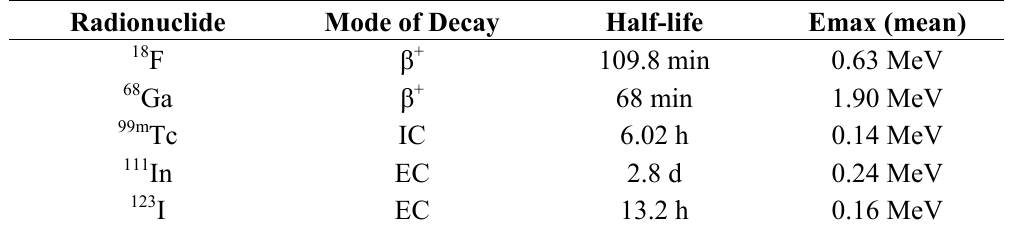
Table 1. Radionuclides involved with the radiolabeling of proteins and their mode of decay. For imaging purposes, the release of γ -rays are preferred either by positron emission, Electron capture (EC) or internal conversion (IC).